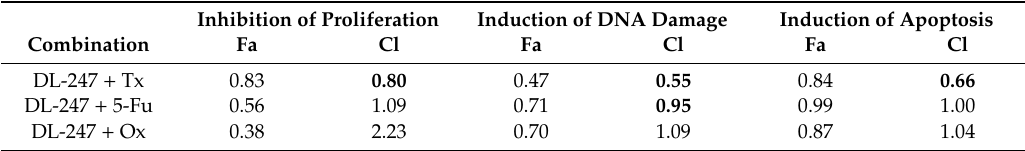
Table 2. Combination index values of DL-247 and anticancer drugs on HL-60 cells.